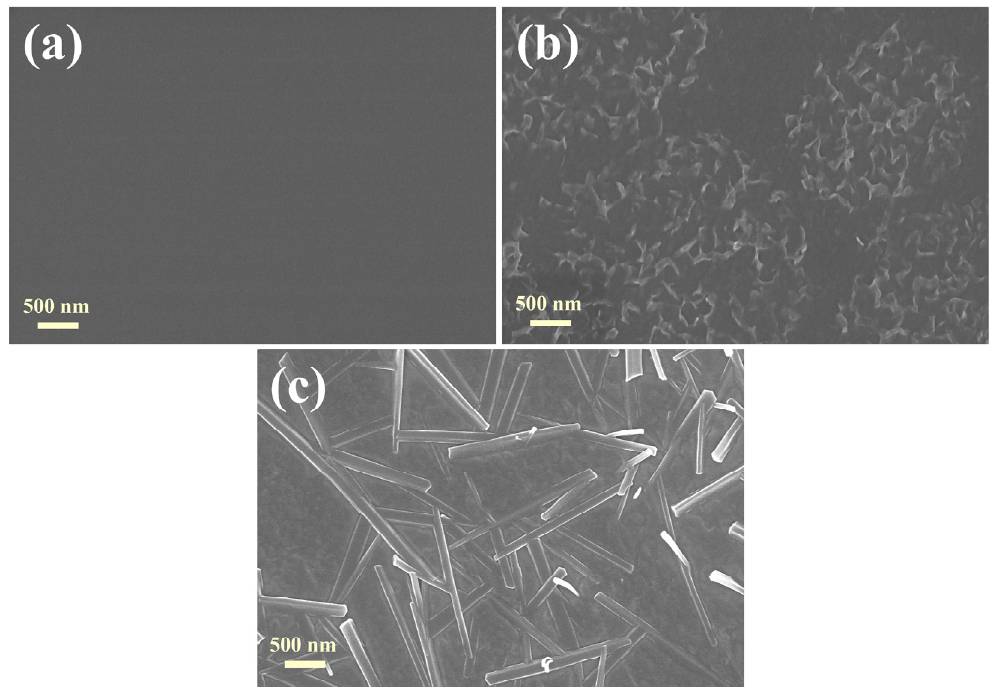
Figure 2. SEM surface morphologies of MgO films placed at 85 °C, 85% R.H for different times: ( a ) 0 h, ( b ) 6 h, and ( c ) 12 h.